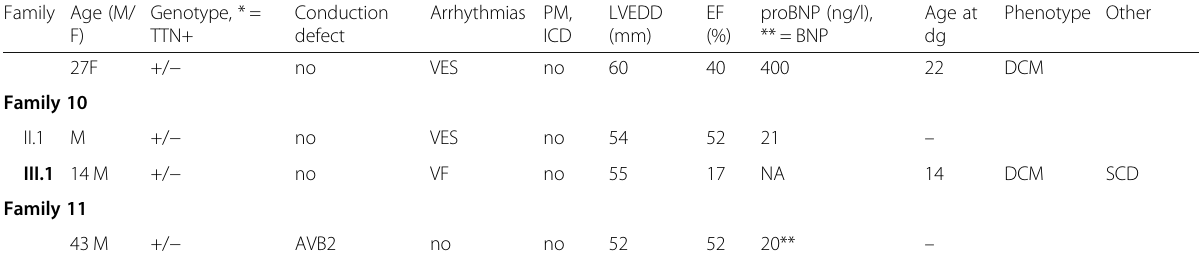
Index patients are marked in bold. Symbols and abbreviations: Age (M/F) age and gender (M: male, F: female); genotype +/ − heterozygous for the DSP p.(Thr2104Glnfs*12), − / − wild type allele, * TTN p.(Val33411Thrfs*32); NA not available; AVB1 – 3 atrioventricular blocks type 1 – 3, (p)L/RBBB (partial)left/right bundle branch block; LAHB left anterior hemiblock; Arrhythmias - VT for ventricular tachycardia: VT means VT episode without information on QRS-axis or morphology, VT m monomorphic VT and VT p polymorphic VT; VES for ventricular extrasystoles: VES, when no information on VES morphology is available, VES m/R means that most of the VES were monomorphic with RV origin (LBBB-morphology) and VES p when most of the VES were polymorphic; AF for atrial fibrillation; VF for ventricular fibrillation; PM pacemaker; ICD implantable cardioverter-defibrillator; CRT-D cardiac resynchronization therapy device; LVEDD left ventricular end- diastolic diameter (mm); LVEF left ventricular ejection fraction (%); ProBNP pro b-type natriuretic peptide, ** BNP b-type natriuretic peptide; Age at dg - age at diagnosis of cardiomyopathy; Phenotype - phenotype at diagnosis; DCM dilated cardiomyopathy; Other – other significant clinical features; SCD sudden cardiac